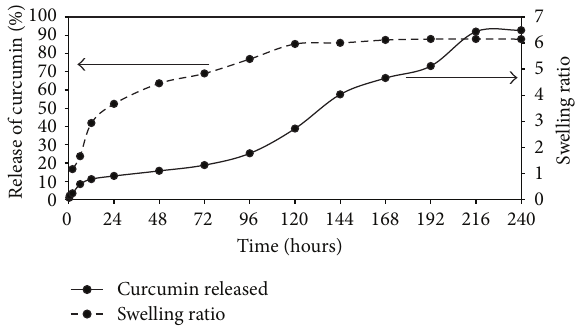
Figure 9: Swelling ratio of starch nanoparticles and release profile of curcumin from starch nanoparticles as a function of